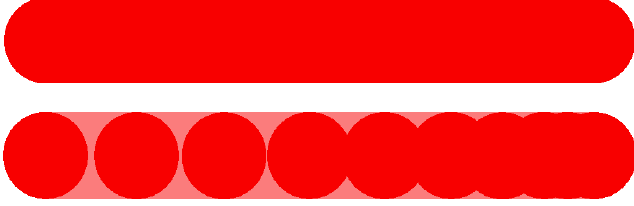
Figure 2. Top : a capsule. Bottom : a capsule sampled by its constituent overlapping spheres, with the growing density of samples going from left to